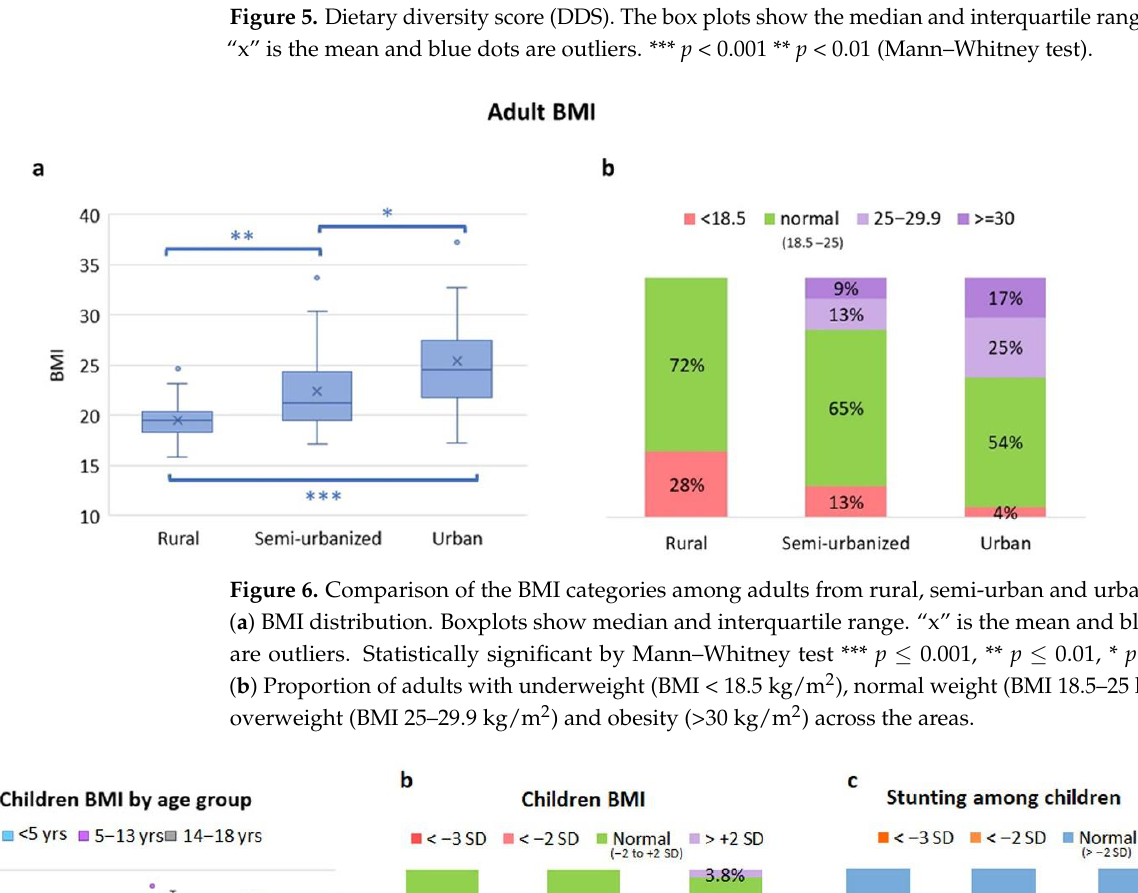
Figure 5. Dietary diversity score (DDS). The box plots show the median and interquartile range (IQR). “x” is the mean and blue dots are outliers. *** p < 0.001 ** p < 0.01 (Mann – Whitney test).